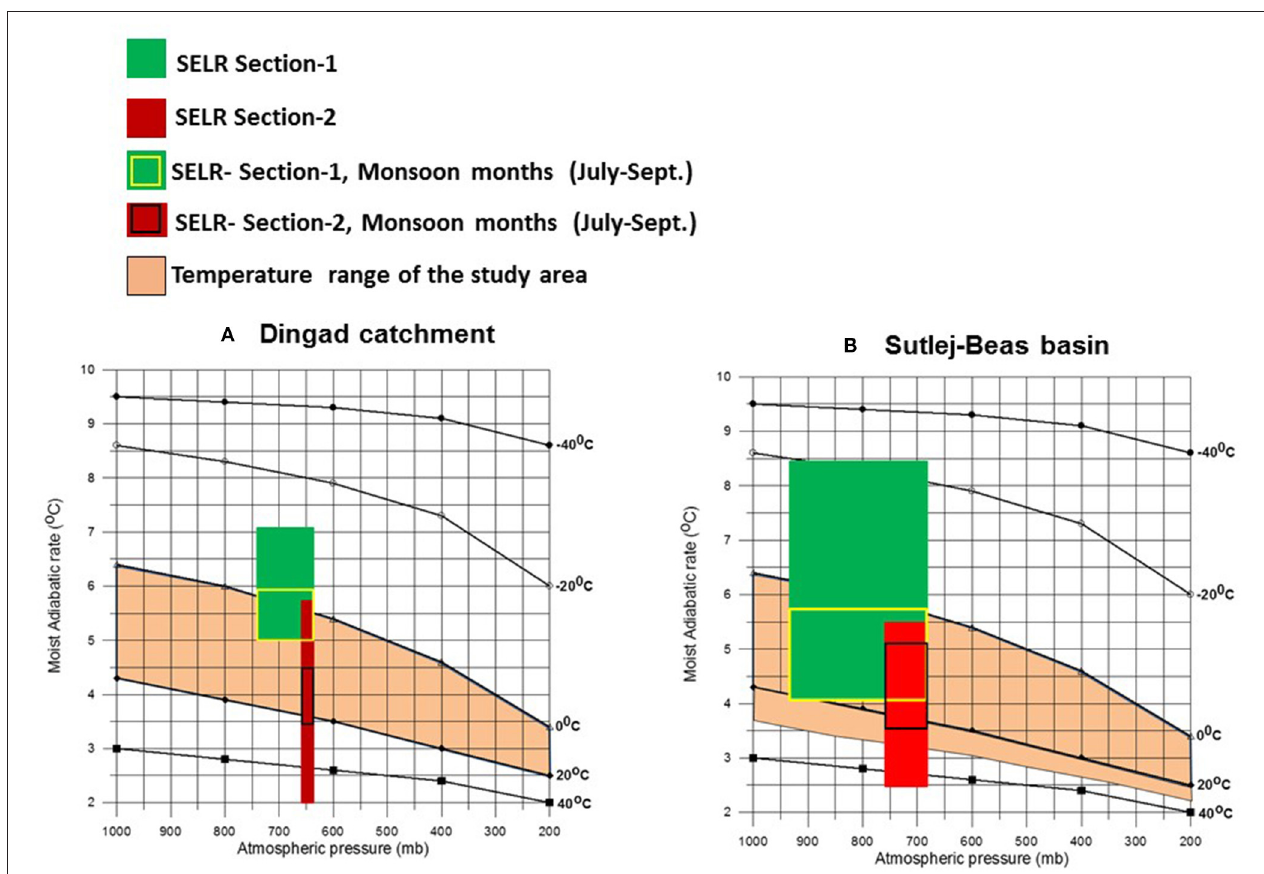
FIGURE 9 | Theoretical saturated adiabatic lapse rate (SALR) under different pressure–temperature combinations calculated using Equation (4) and observed monthly SELR under monsoon regime (A) Dingad catchment and (B) Sutlej–Beas basin. Green blocks showing the extent of mean monthly SELR of section 1 and Red blocks for section 2. Yellow outline represents the SELR range of section 1 during the monsoon months and blue outlines for section 2. Both fall within the theoretical SALR range suggesting the influence of moisture influx and related monsoon lowering of SELR. Higher SELR of April, May, and June months is also common to all the study